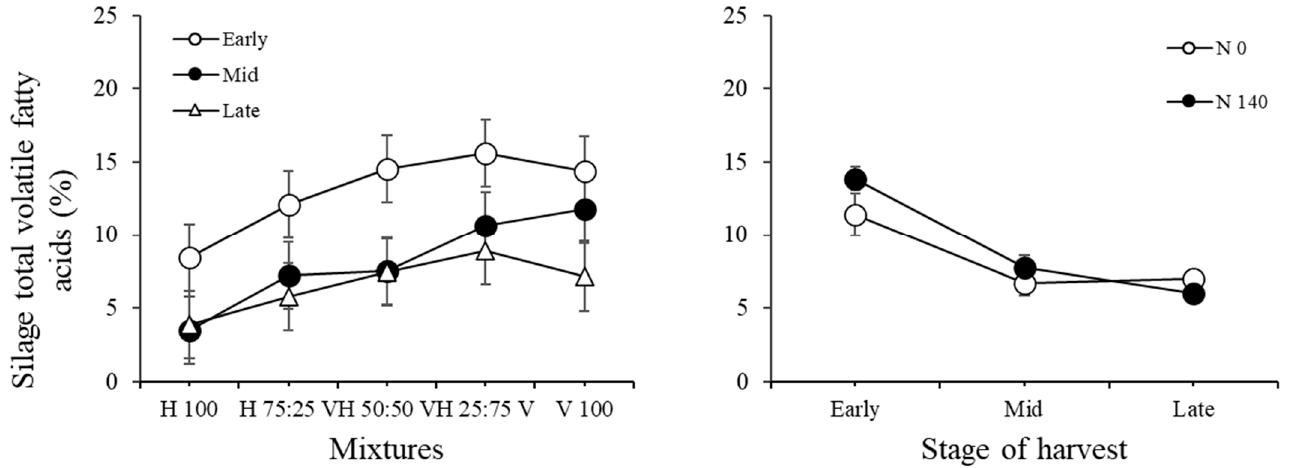
Figure 16. Silage total volatile fatty acids concentration as affected by MX mean effect ( left ) and SH × NF interaction ( right ). On the left, values are LSmeans across all treatments along with standard error estimate of the LSmeans since the design was unbalanced between the faba bean crop ( n = 9) compared to the mixtures and the barley crops ( n = 18). On the right, only data of the barley-containing treatments were used. Each point represents the arithmetic mean ( n = 24) and its computed standard